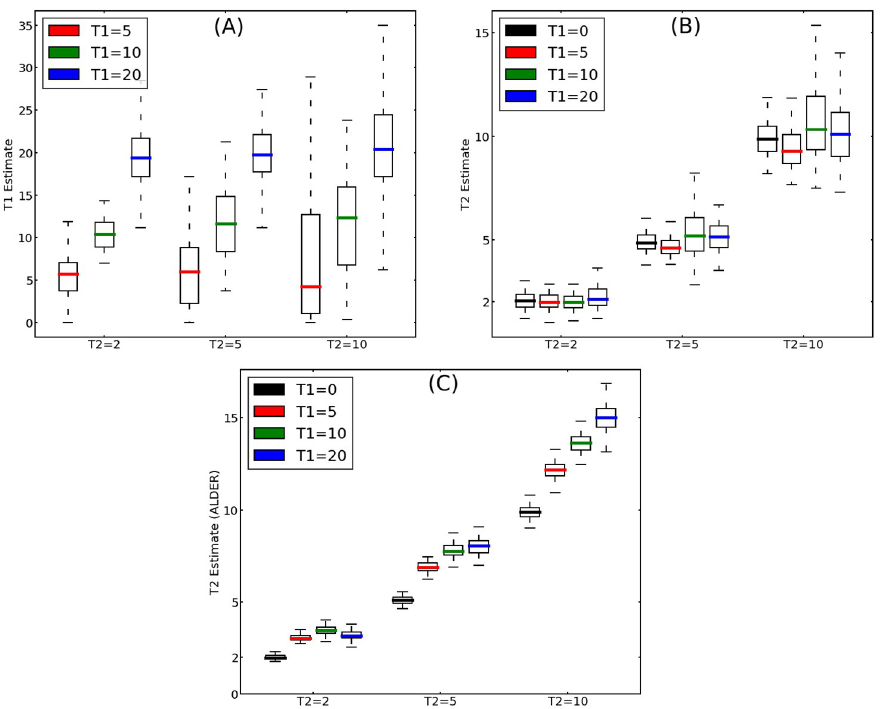
Fig 5. Accuracy of estimates of T 1 (A) and T 2 (B), and ALDER estimates of admixture time (C) as a function of other parameters. Twelve admixture scenarios, T 1 2 {0, 5, 10, 20} and T 2 2 {2, 5, 10}, were simulated 100 times each. The admixture probabilities were fixed at M 1 = 0.3 and M 2 = 0.2. The colored bars give the medians of estimates for each of these twelve cases, the boxes delimit the interquartile range, and the whiskers extend out to 1.5 times the interquartile range. As the time between the two pulses of admixture increases, the error in the estimates decreases (for this reason we do not include T 1 = 0 accuracy estimate, in this case the results become unreasonable). Consistent with the simulations shown in Fig 1, there is limited power to estimate the time of the more ancient admixture pulse when T 2 > T 1 . ALDER estimates a single admixture time which corresponds to T 1 = 0.